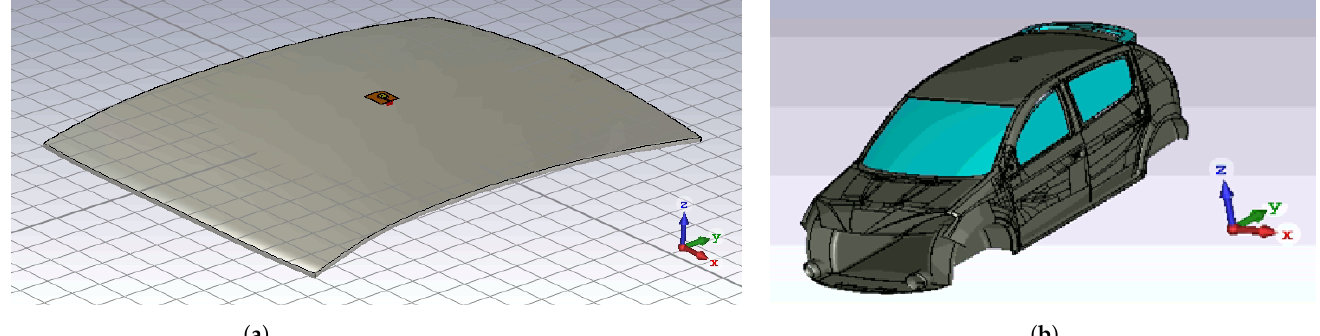
Figure 1. Vehicle model preparation in CST MWS software to obtain the data. ( a ) Simplified vehicle model, just the roof. ( b ) Full car model.